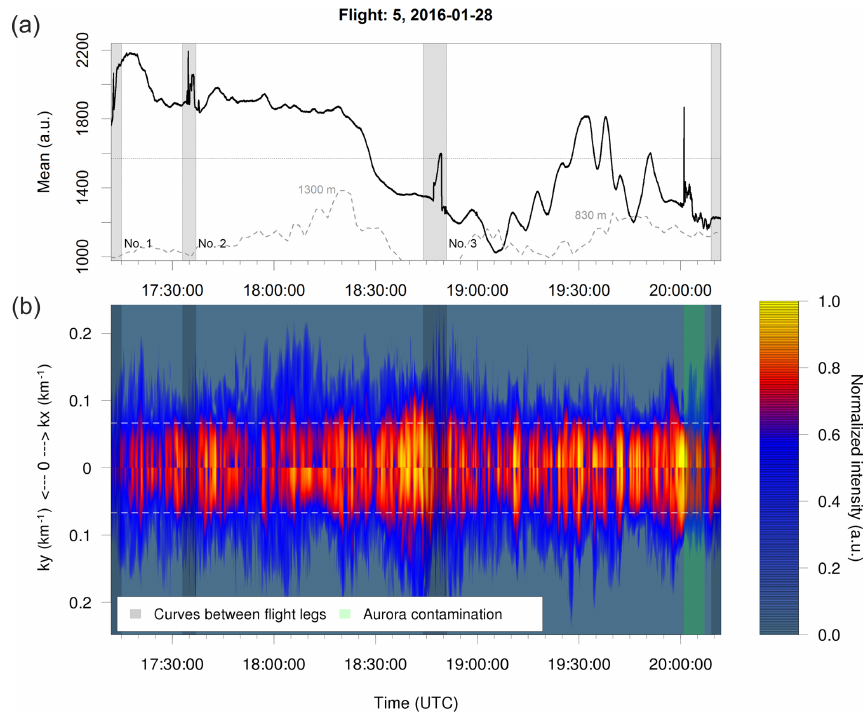
Figure 11. Same as Fig. 8 but for flight